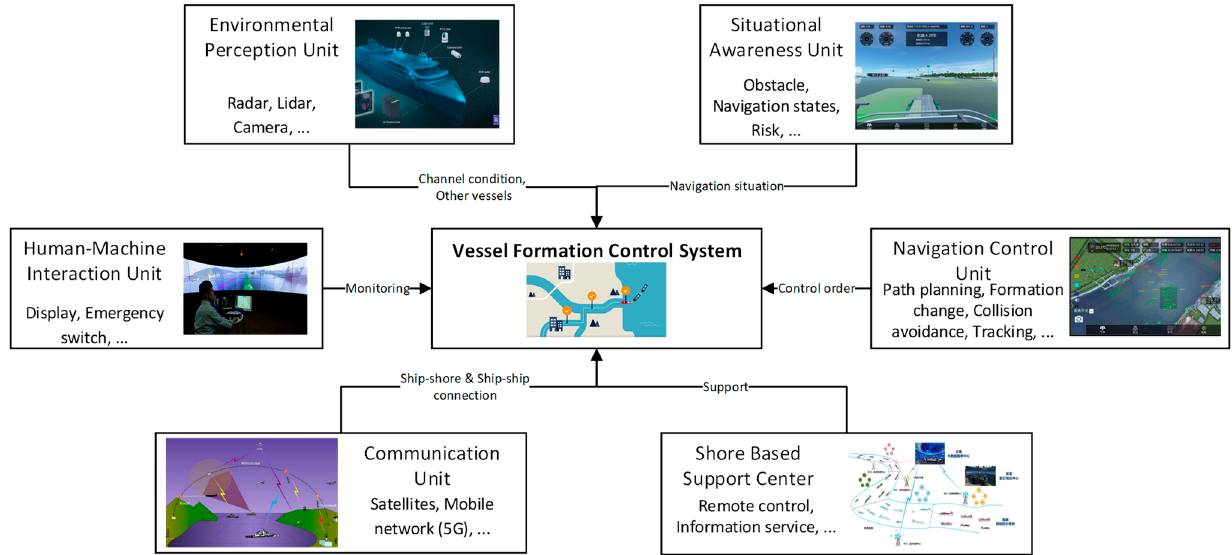
Figure 4. NOVIMAR project development.